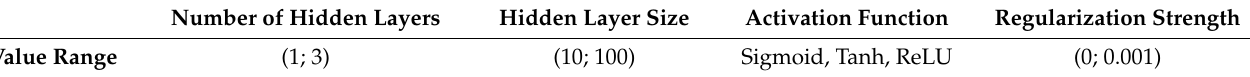
Table 9. Hyperparameters of the ANN model.